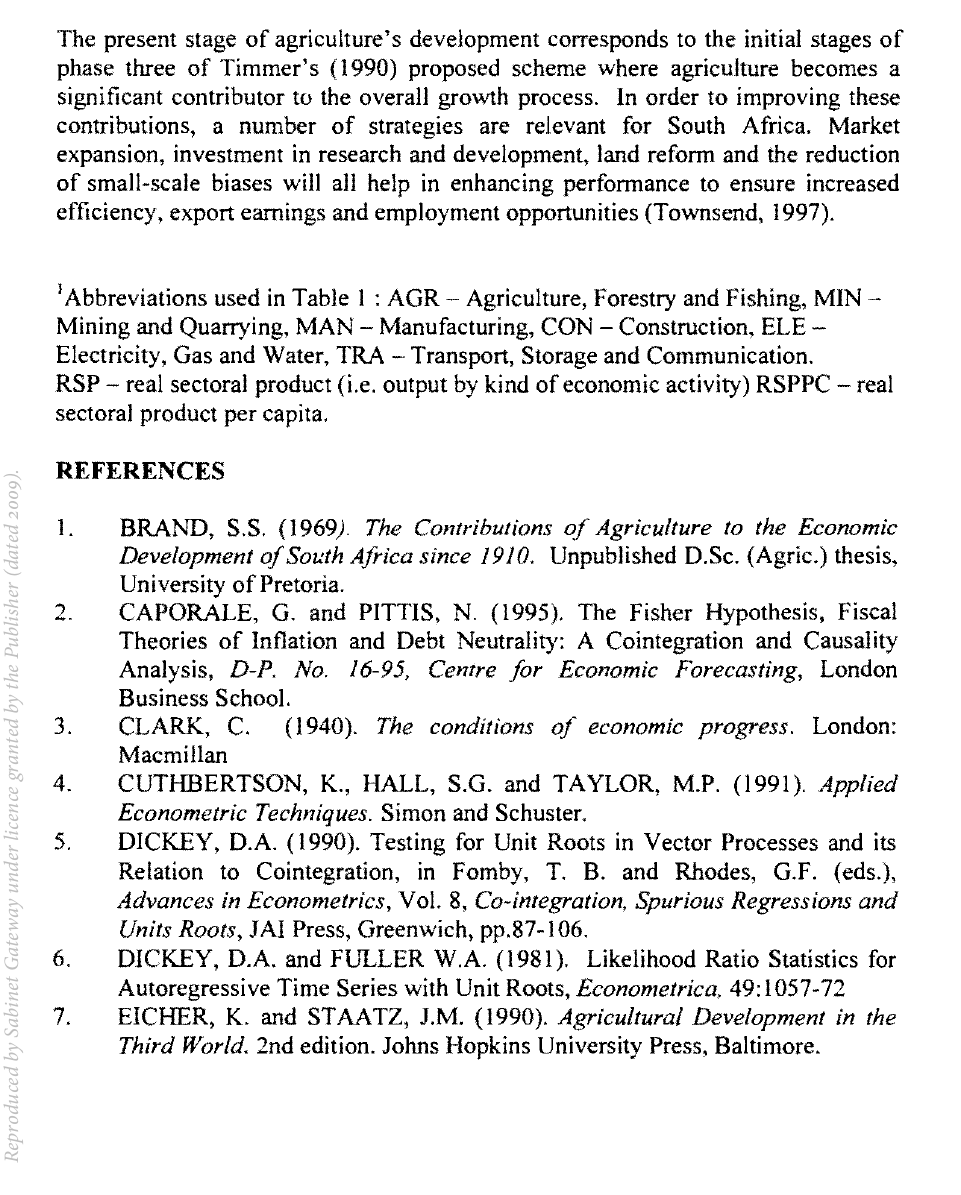
'Abbreviations used in Table 1 : AGR ~ Agriculture, Forestry and Fishing, MIN Mining and Quarrying, MAN - Manufacturing, CON - Construction, ELE Electricity, Gas and Water, TRA Transport, Storage and